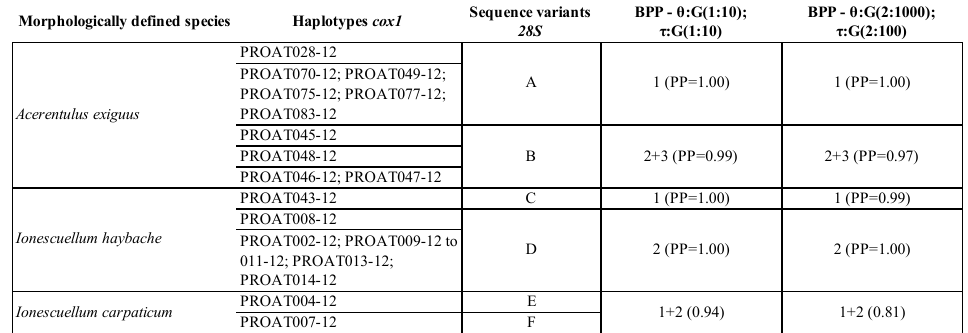
Table 4. Species delimitation testing ( cox1 and 28S ). First column lists species as morphologically defined following BOLD annotations. Second column reports BOLD identifiers for each specimen; specimens sharing the same cox1 haplotype (after alignment trimming) are grouped using thin horizontal lines. Third column indicates sharing of 28S sequence among specimens, see BOLD for sequence data. Columns 3 and 4 show results of BPP testing on species delimitation; an open cell indicates a cluster of the corresponding specimens listed in the second column; open cells carry a numerical indication of the corresponding sublineage (for cross table reference) and statistical support for the group expressed as posterior probabilities.